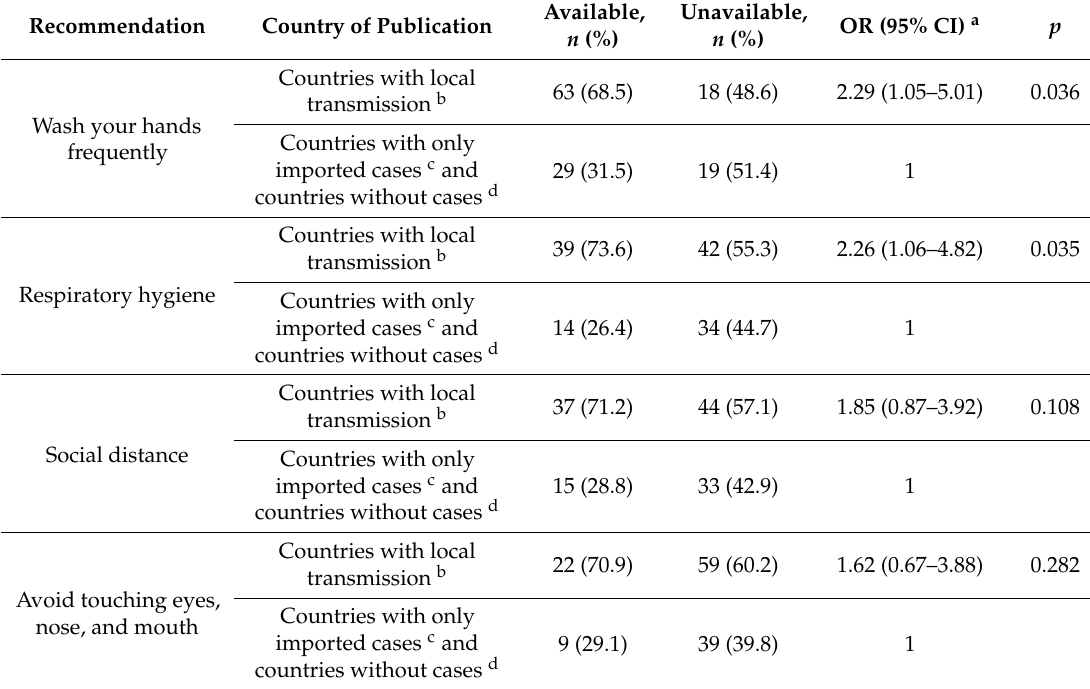
Table 3. Recommendations to prevent transmission of COVID-19 according to the type of transmission of COVID-19 in the country of the video.